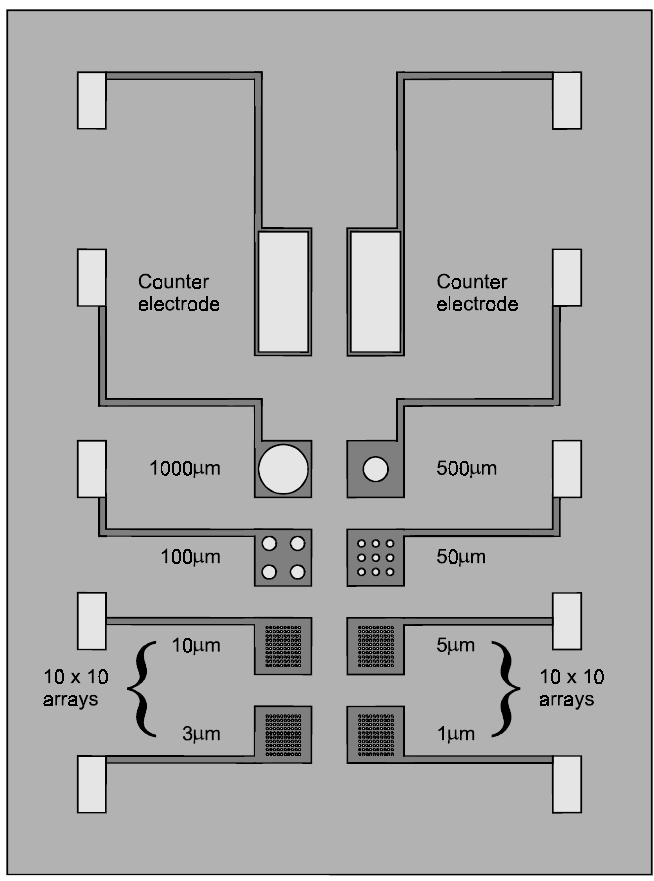
Figure 1. Schematic representation of the design of a Multi MEA chip coated with Si